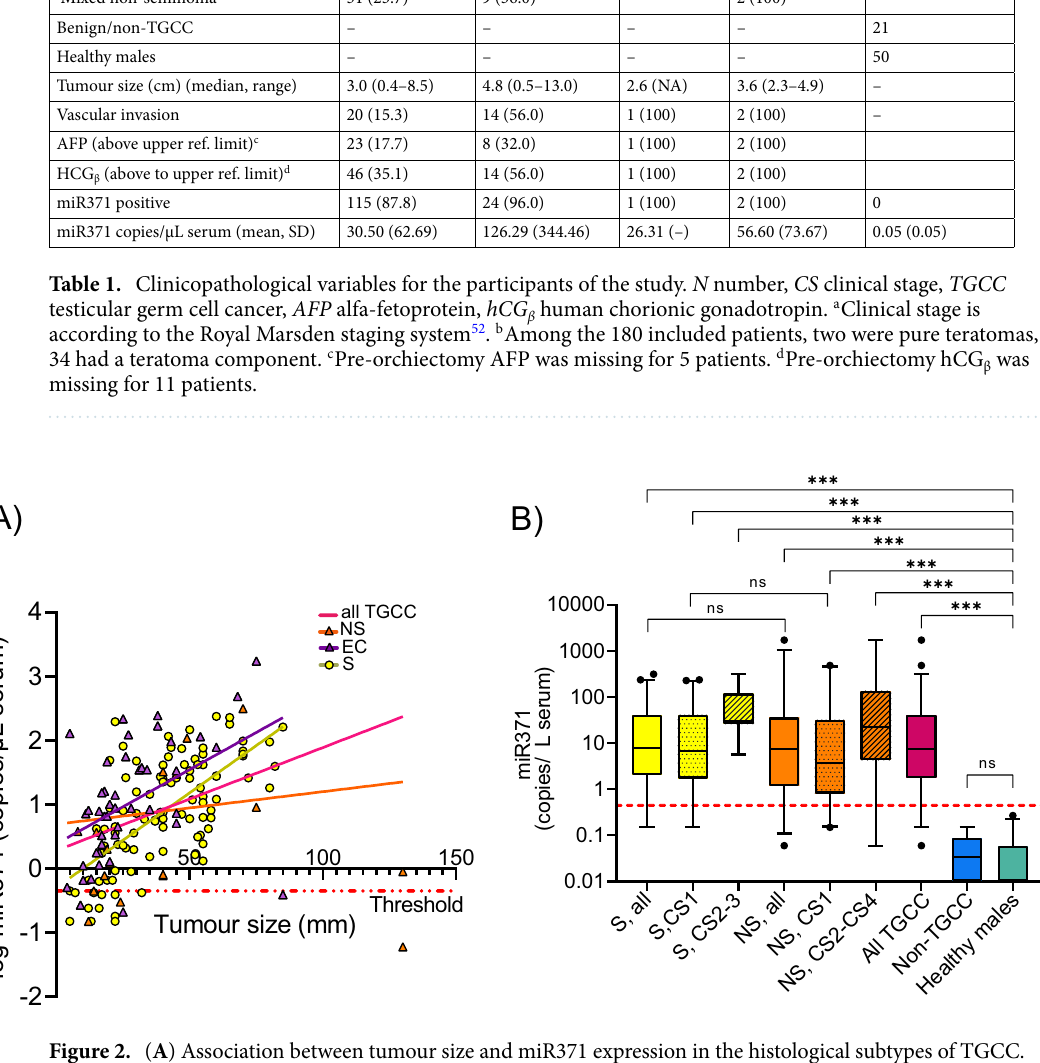
Figure 2. ( A ) Association between tumour size and miR371 expression in the histological subtypes of TGCC. The tumour size is plotted against miR371 expression. Regression lines for the subtypes are shown. A tumour was classified as EC if >20% of the tumour bulk consisted of EC cells. NS non-seminoma, EC embryonal carcinoma, S seminoma. ( B ) MiR371 expression prior to orchiectomy across the histological sub-types and clinical stages. The threshold for calling miR371 as positive is shown as a dotted, red line. Shown are mean values with 95% confidence interval. S seminomas, NS non-seminomas, TGCC testicular germ cell cancer, TGCCC, patients included with suspected TGCC, but diagnosed with other benign and malignant conditions; Healthy males, blood donors. *** P < 0.001; ** P < 0.01; * P < 0.05; ns P > patients were miR371 negative (six non-seminomas and eleven seminomas). None of these were pure teratomas. One of the negative non-seminoma patients was CS2 and had a 13 cm large tumour classified as 60% teratoma and 40% seminoma, while three were embryonal carcinoma CS1 and two were mixed non-seminomas CS1. All negative seminomas were classified as CS1. One of the miR371 negative patients had hCG β slightly above the threshold, the other 16 were negative for both hCG β and AFP.